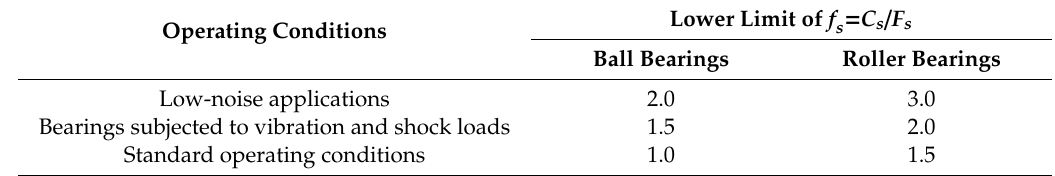
Table A1. Values of permissible static load factor fs [33].